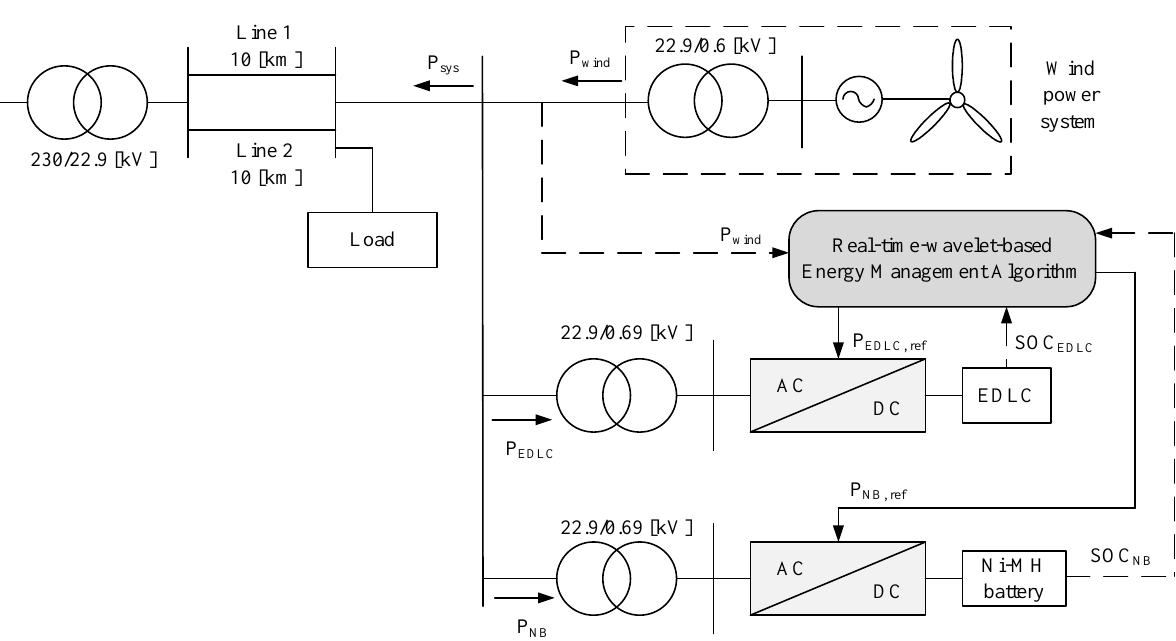
Figure 1. Wind-hybrid energy storage system (HESS)